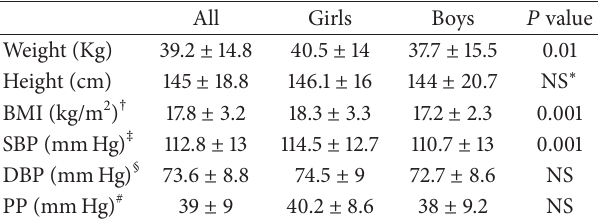
Table 2: Clinical characteristics of the subjects studied.